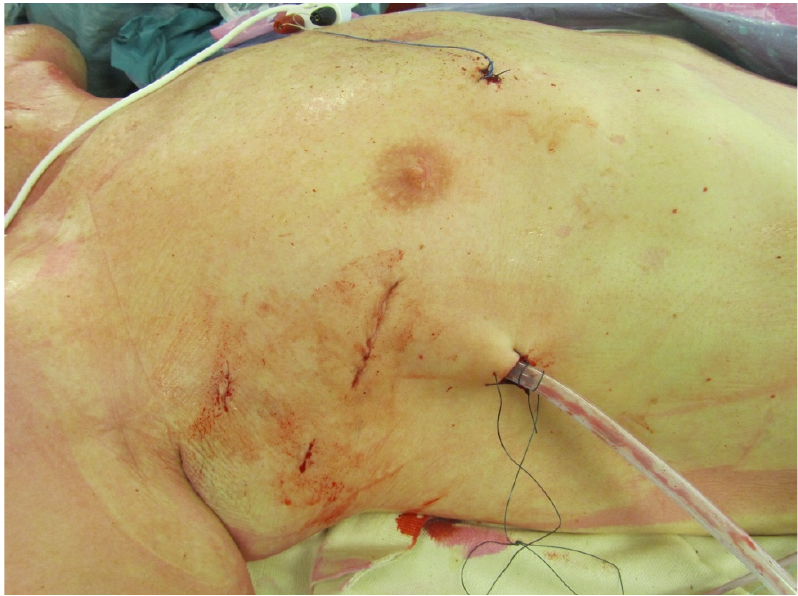
Figure 1. Scar of minimally invasive access for mitral valve surgery.